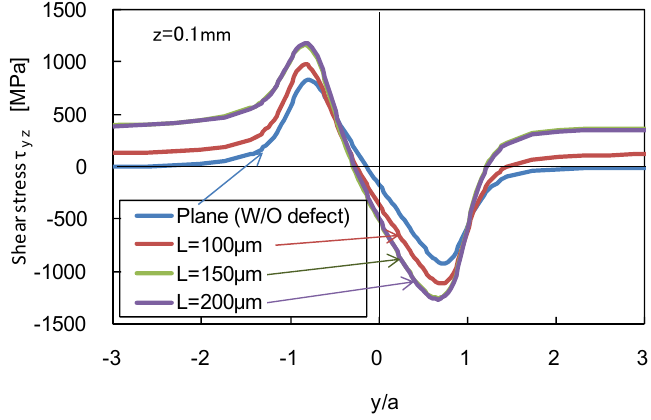
Figure 7: Variation in shear stress at 0.1 mm depth during rolling contact obtained from elastic–plastic FE analyses.